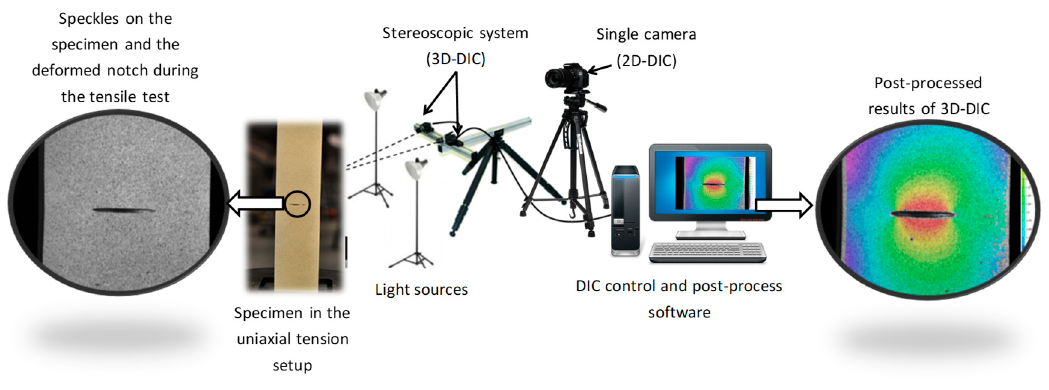
Figure 2. DIC and test set